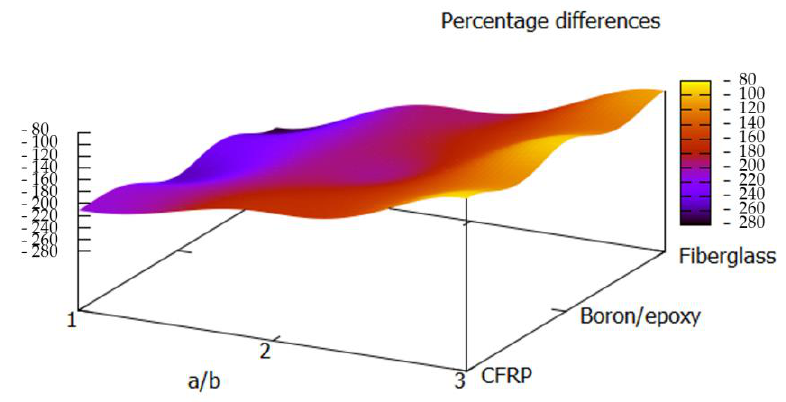
Figure 7. Percentage di ff erence between the buckling loads of the optimised plates and the plates with the stacking sequence from